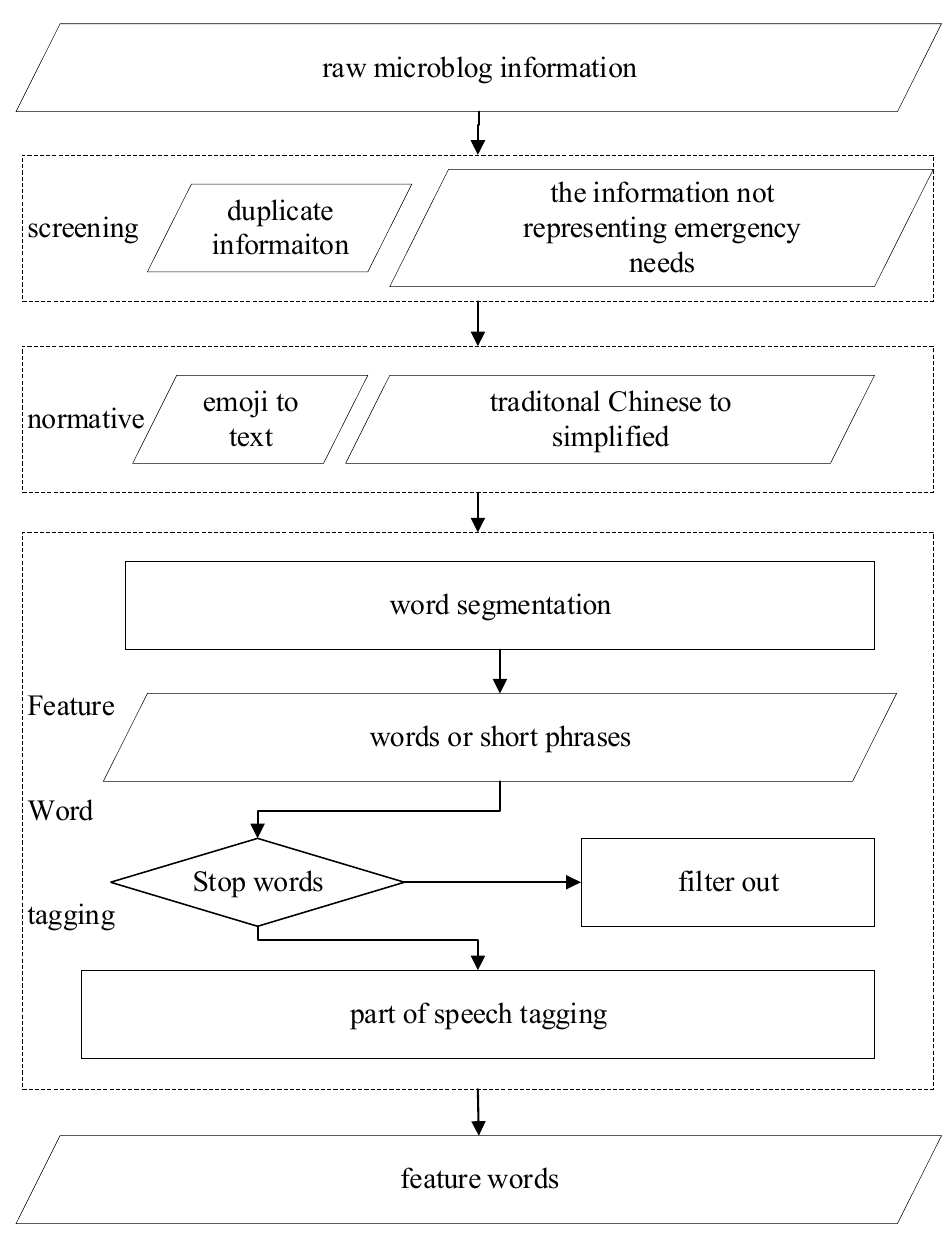
Figure 1. Data preprocessing flow chart.